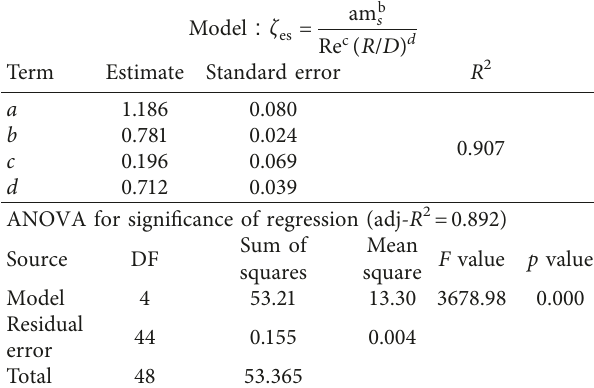
Figure 10: Comparison of the additional pressure loss coefficient of solid flow between experimental values and predicted values. Table 2: Analysis of nonlinear regression.